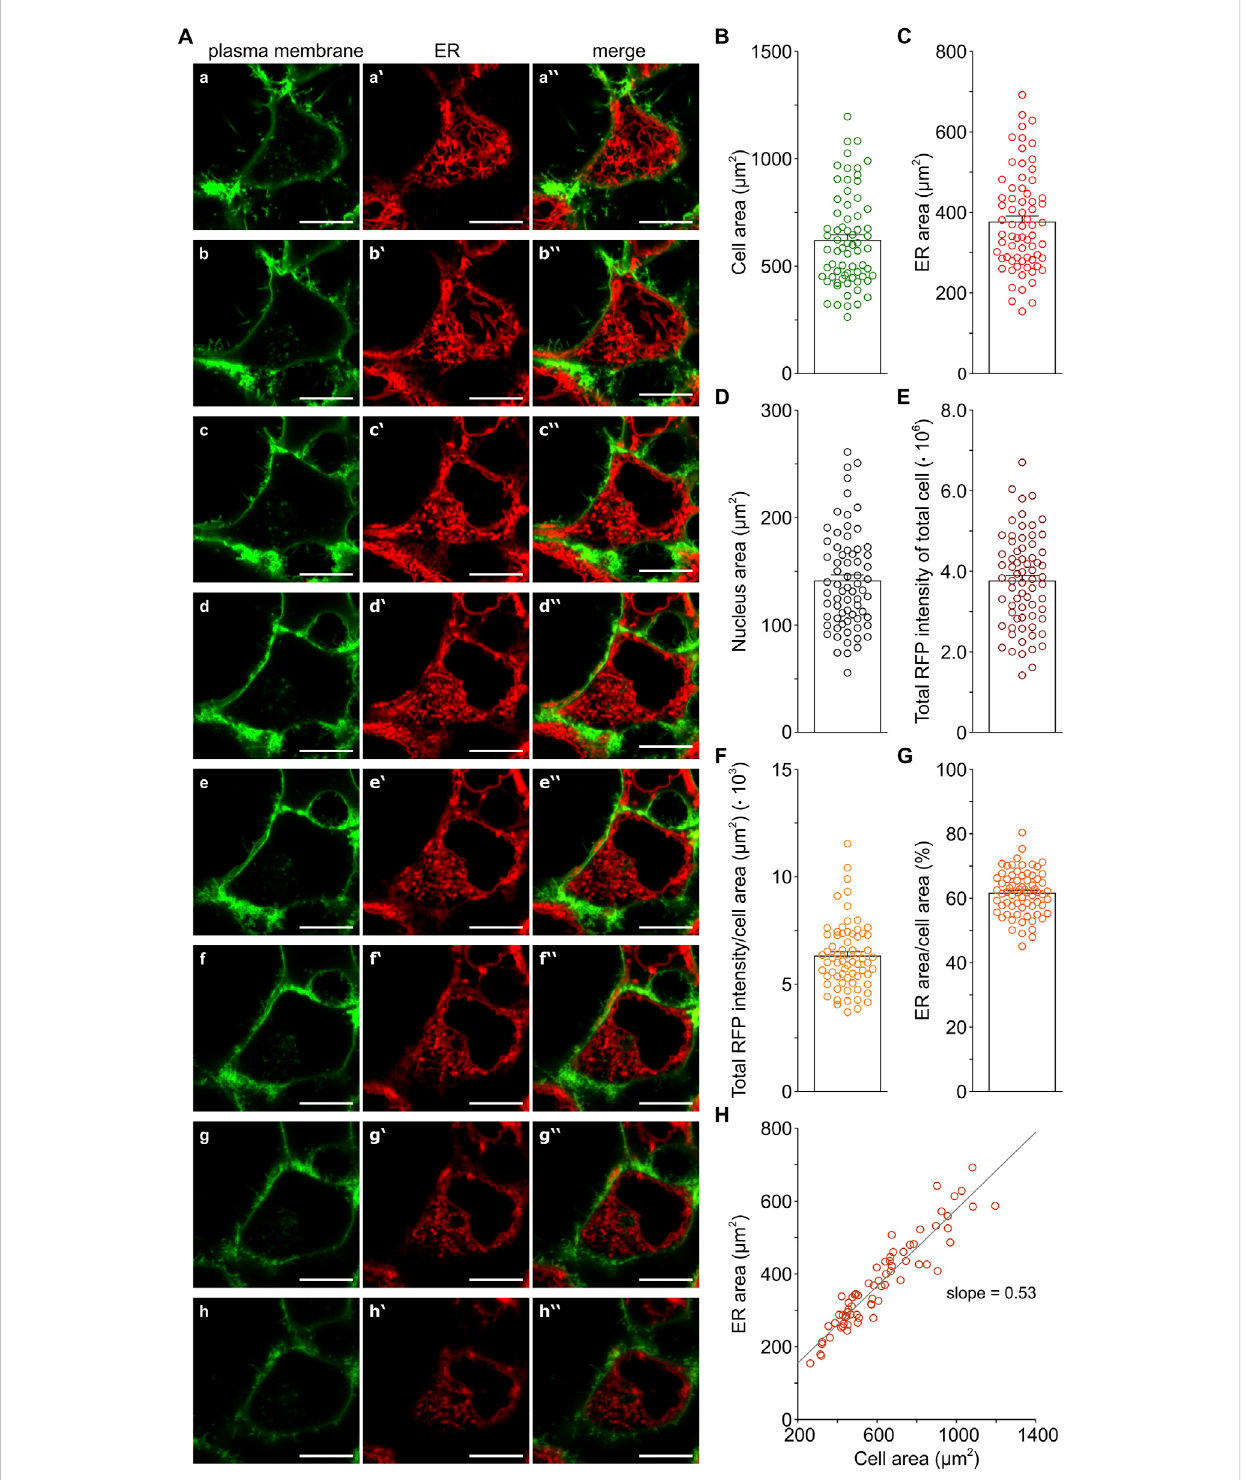
FIGURE 1 Morphology of the ER in HEK-293 cells. The plasma membrane (green) was stained with an GFP-based marker (Cell Mask Plasma Membrane Stain) and the ER (red) with an RFP-based ER tracker (Bodipy TR Glibenclamide), as described in Methods. Representative z-stack images show the plasma membrane (A – H) andERstaining( A , a ! - h ! )aswellasthecorrespondingmergedimages( A , a ‶ -h ‶ )fromaHEK-293cell.Imagesofthez-stackarelinedup from the lowermost ( a , a ! , a ‶ ) to the uppermost ( h , h ! , h ‶ ) z-plane with respect to the coverslip. Scales represent 10 µm. The areas occupied by the cell, ER, and nucleus were determined for individual HEK-293 cells in the z-stacks (B – D) . The amount of ER staining was measured as the absolute and normalised total RFP intensity per cell (E,F) . The fraction of the cytosol occupied by ER structures was calculated as ER area/cell area (G) . The plot of ER area vs. cell area shows a linear correlation with a slope of 0.53 and a correlation of r 2 = 0.88. Bar charts represent mean ± SEM; symbols show single cell data. Number of cells: